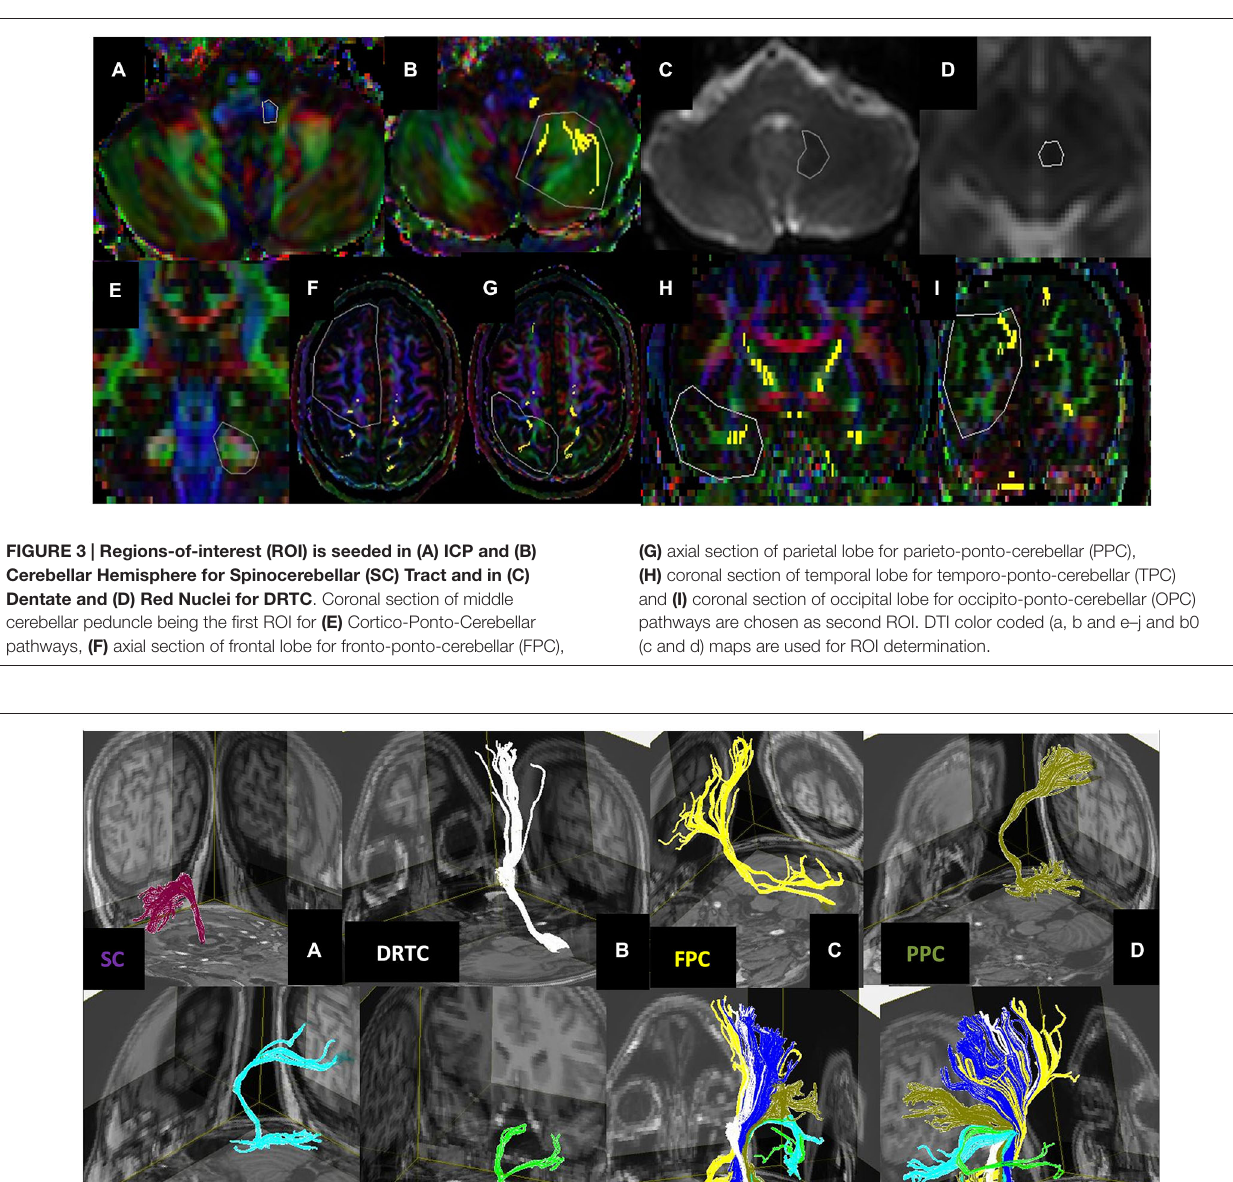
(F) Temporo-Ponto-Cerebellar pathways . All these cerebellar pathways are illustrated together with corticospinal tract (dark blue) in panels (G,H)